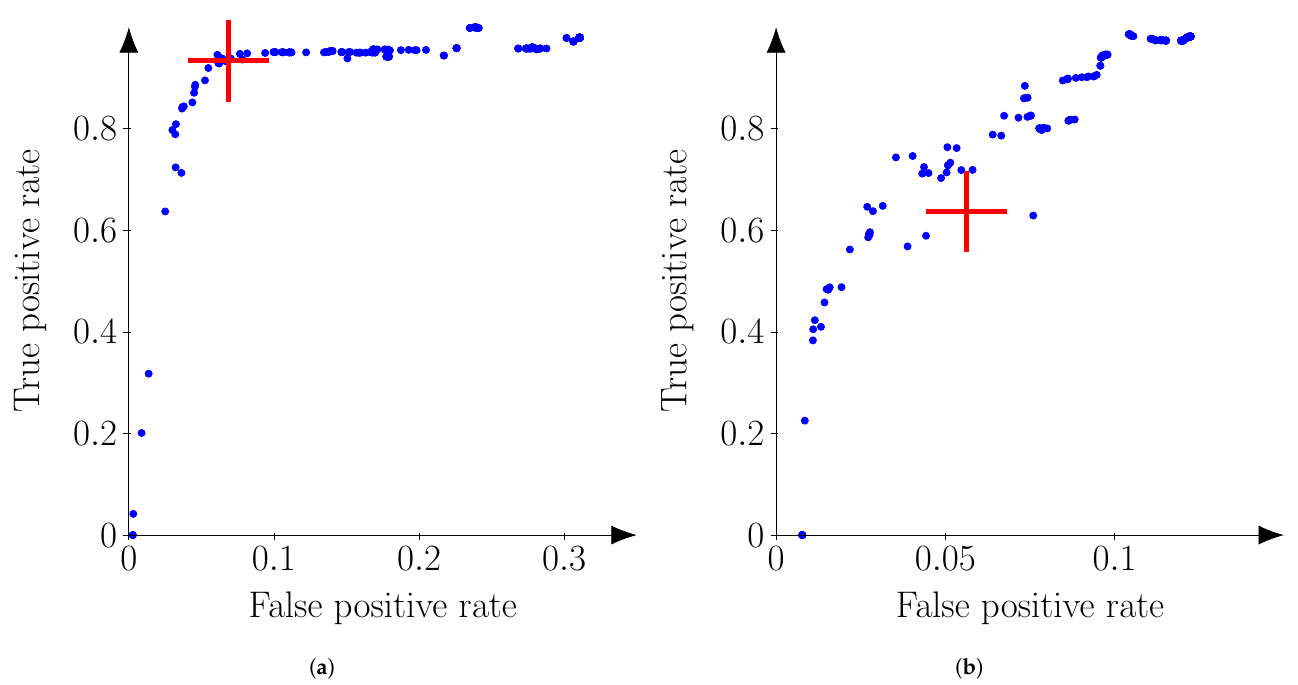
Figure 10. Receiver operating characteristic (ROC) curves. Blue points represent different threshold values, the red cross is the automatic threshold. ( a ) “statue-robot”. ( b )